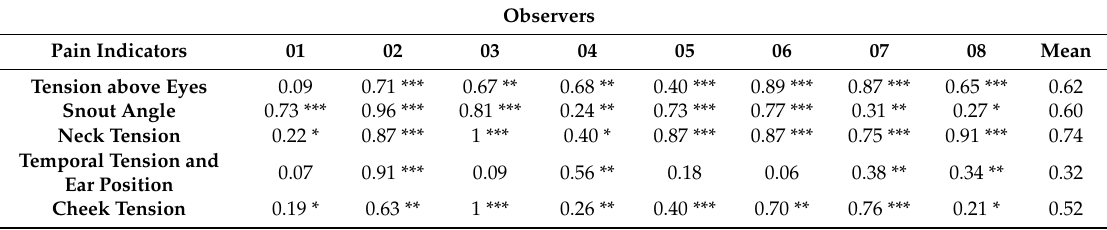
Table 3. Individual and mean intra-observer reliability (Kappa Coe ffi cient) of eight observers (from 01 to 08) for each facial action unit (FAU) of 12 sow face images repeated twice each during the 60-images